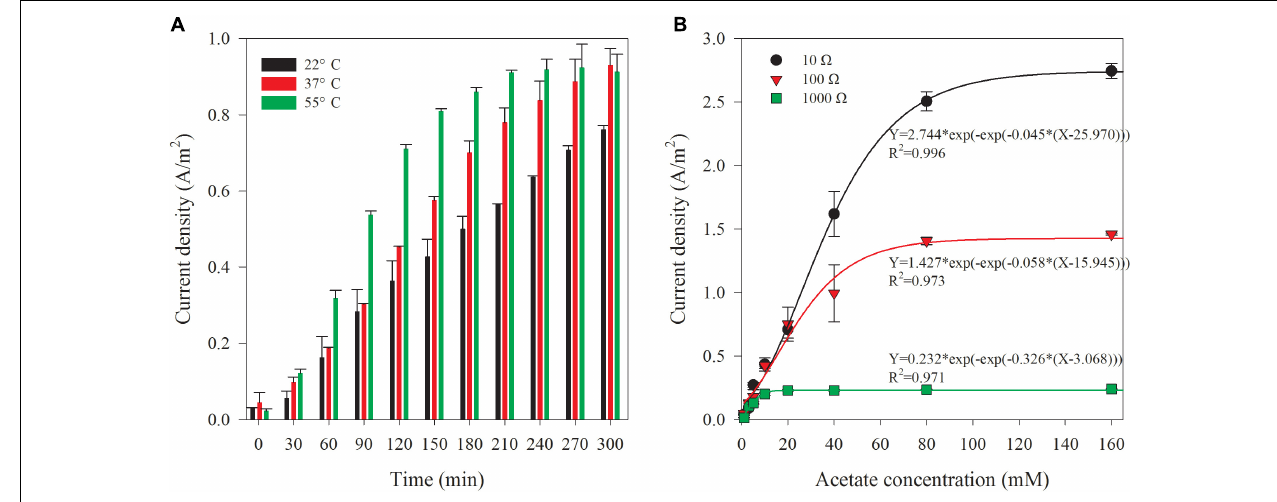
FIGURE 5 | Current density variation along with time corresponding to the different initial temperature of sample (A) and the comparison of the current density from the biosensor with different external resistances at the reaction time of 5 h (B) .